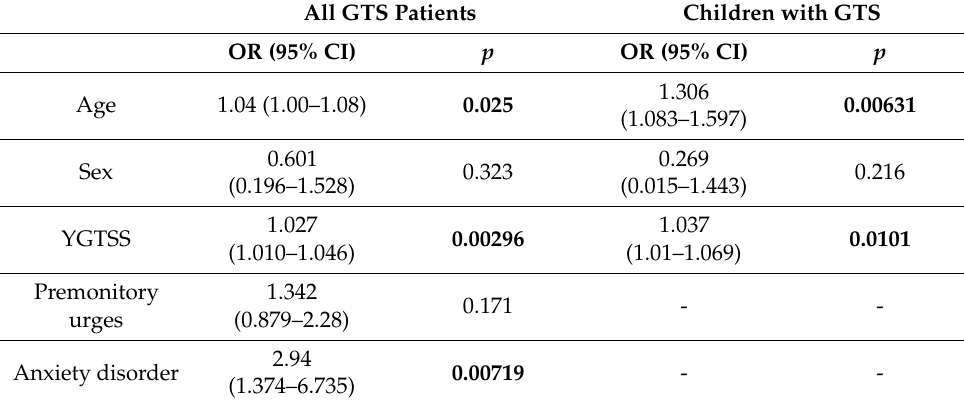
Table 3. Logistic regression analysis for the predictors of lifetime CTPh in